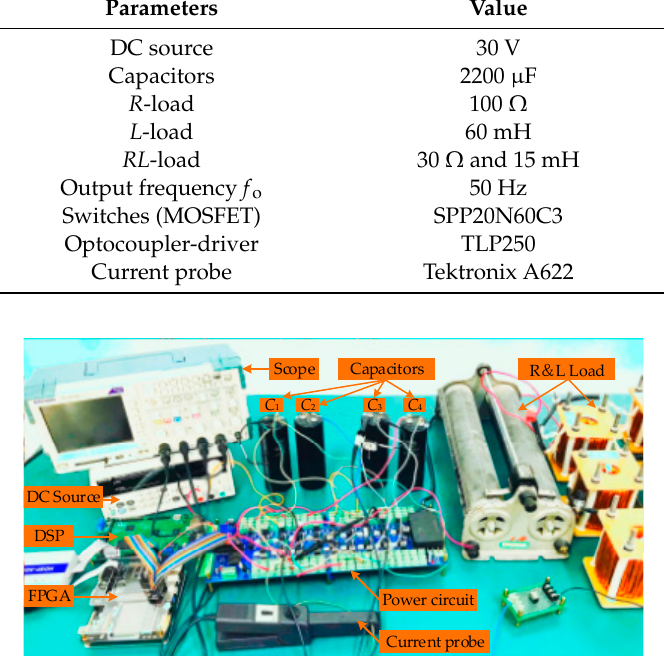
( b ) Figure 17. Experimental waveforms. ( a ) Output voltage and current. ( b ) Capacitor voltages. The ability of integrating the pure inductive load of the proposed inverter is validated by conducting the L -load. The experimental results are shown in Figure 18. The current lags behind the voltage by 90°.